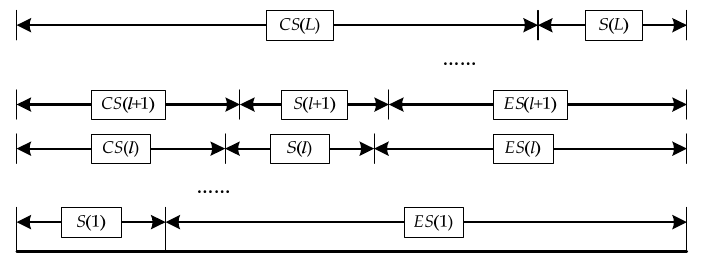
Figure 4. Operation ‐ based rolling window. Figure 4. Operation-based rolling